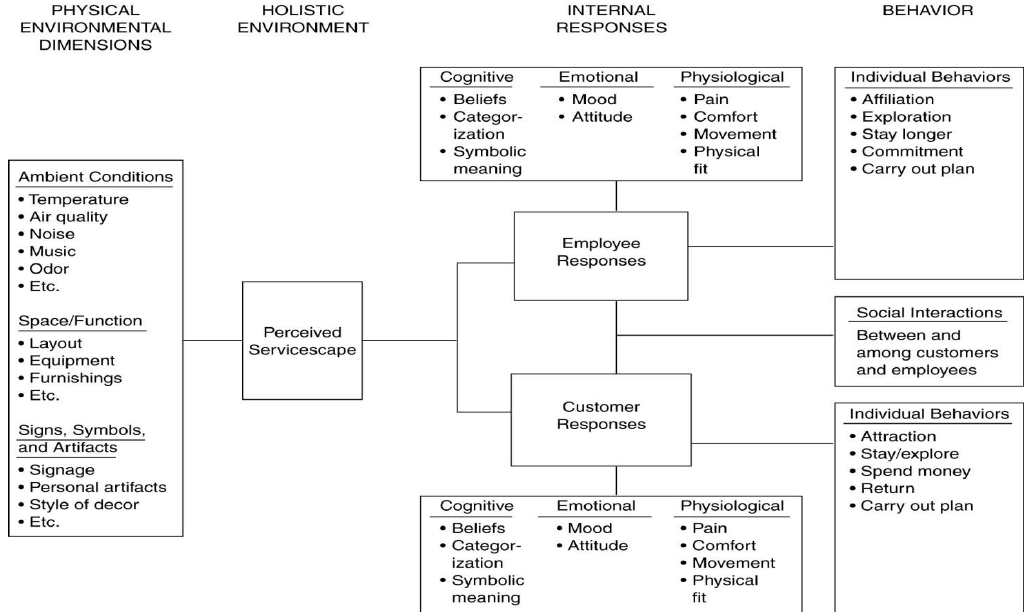
Figure 1: Bitner's Servicescape Model